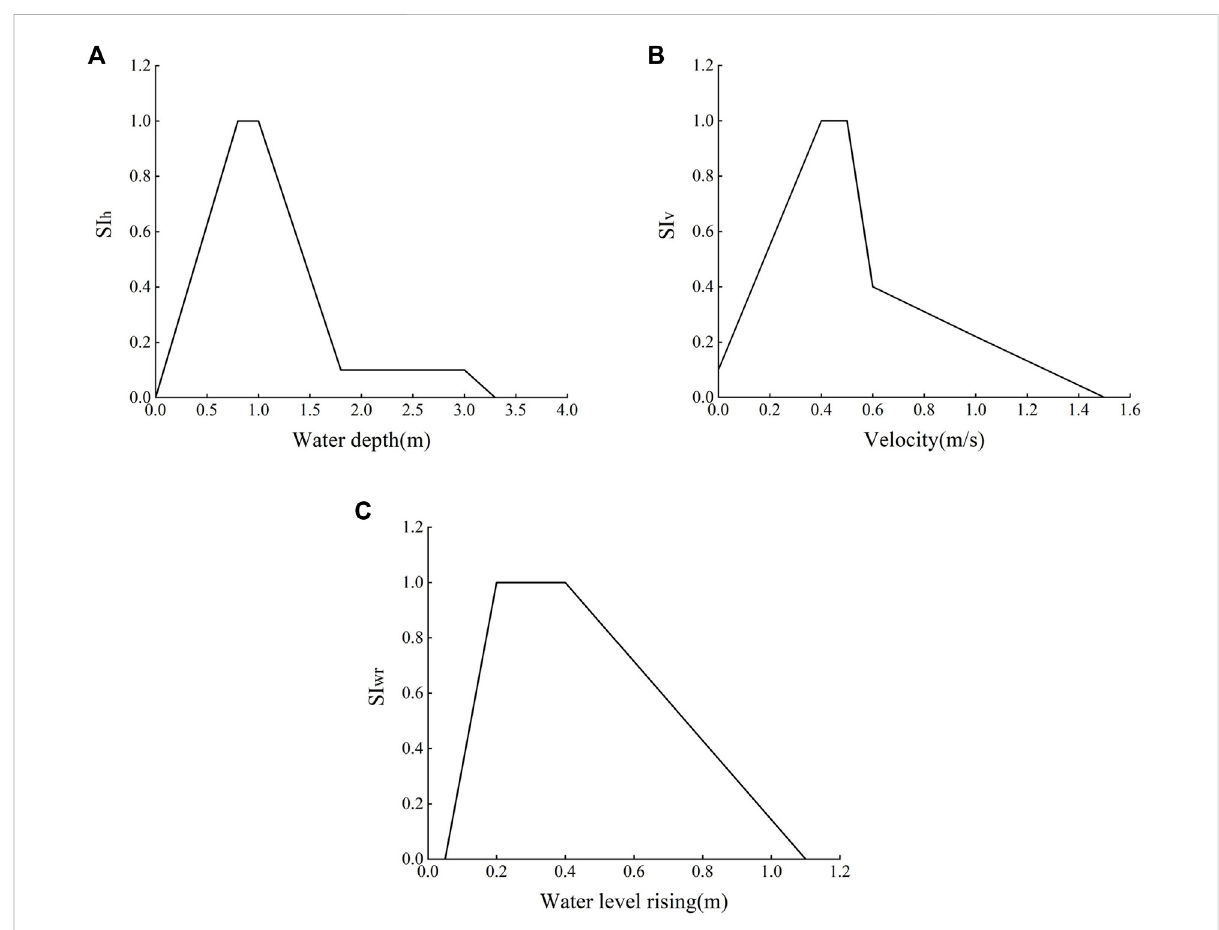
FIGURE 3 Suitability curves ofdifferenthabitatfactors inthehabitat suitabilitymodelusedinthisstudy: waterdepthsuitabilitycurve (A) ,velocitysuitability curve (B) , and water level rising suitability curve (C)